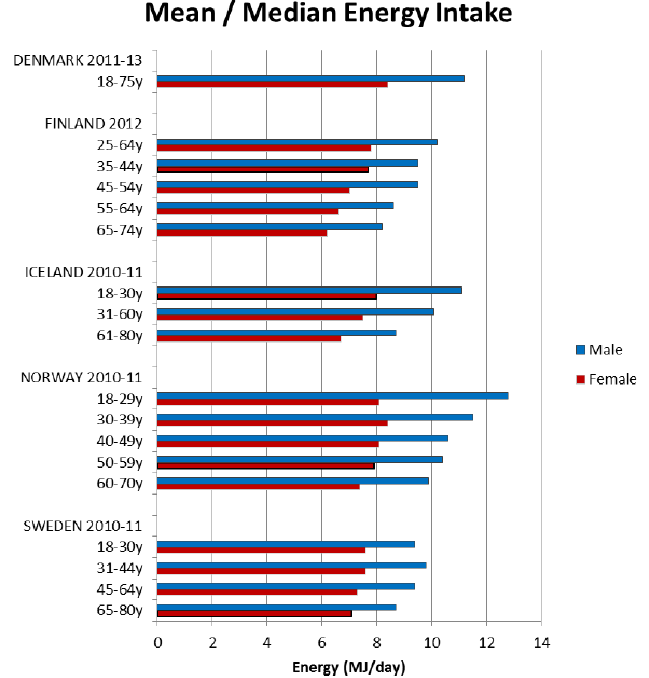
Figure 2. Mean/median adult energy intake (MJ/day) for Northern European countries (excluding supplements).